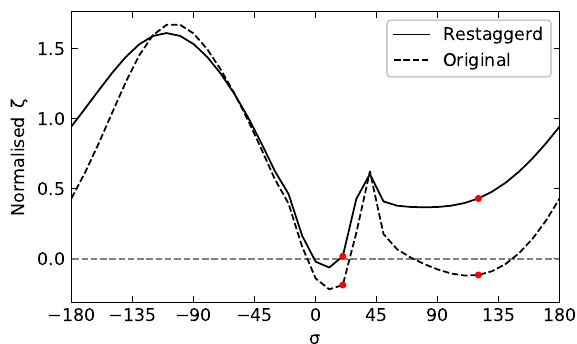
Figure 10. CFD prediction of normalised damping for “restaggered”